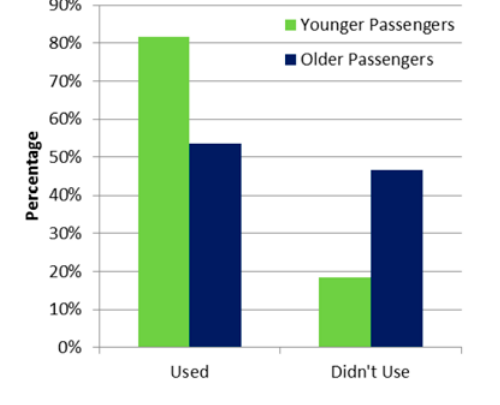
Fig. 1. Usage by age Table 2. Usage by age